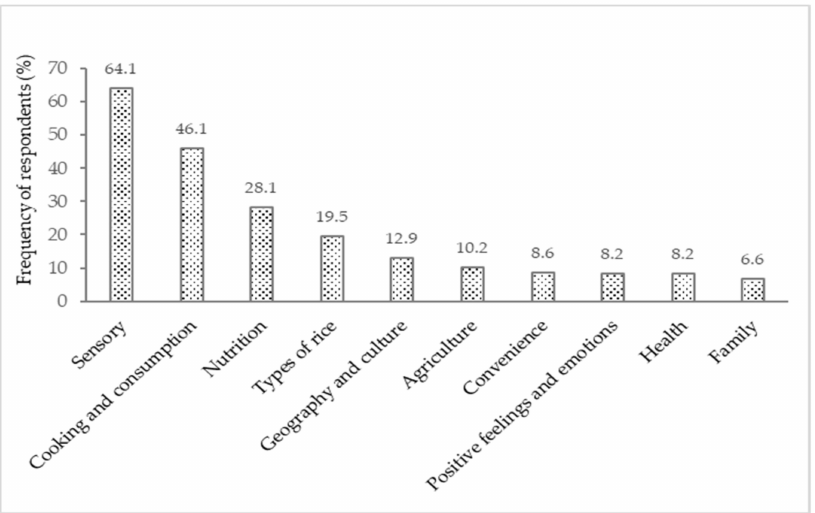
Figure 1. Word frequency of the twenty most evoked words for the stimulus: ( a ) “rice” and ( b ) “rice with low glycaemic index”. * Cabidela rice is a traditional Malandro rice dish of the gastronomy of the Northern region of Portugal made with Carolino rice, poultry, and chicken blood with vinegar, where the offal is also incorporated, resulting in a creamy/saucy rice with meat served as a main course.